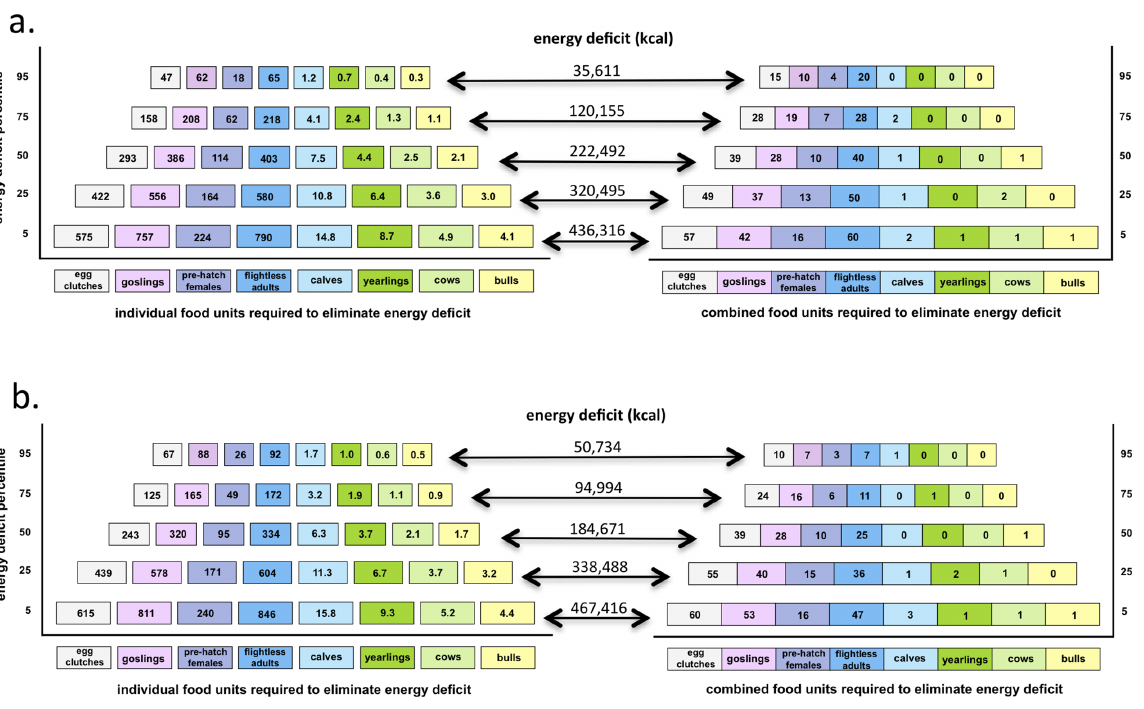
Fig 5. The number of indivudal units (left) or combinations (right) of food items that could satisfy total energy deficits (numbers on arrows in center) of starving male polar bears onshore for 180 days. The levels of energy deficits vary from the lowest (95%) to the highest (5%) and are presented for scenarios in which the bears have been resting (a) or walking (b) on land prior to starving. A 2 km d -1 energy cost associated with movement is depreciated from daily food value calculations. If costs to procure food items exceed this movement cost, numbers of individual food requirements may be